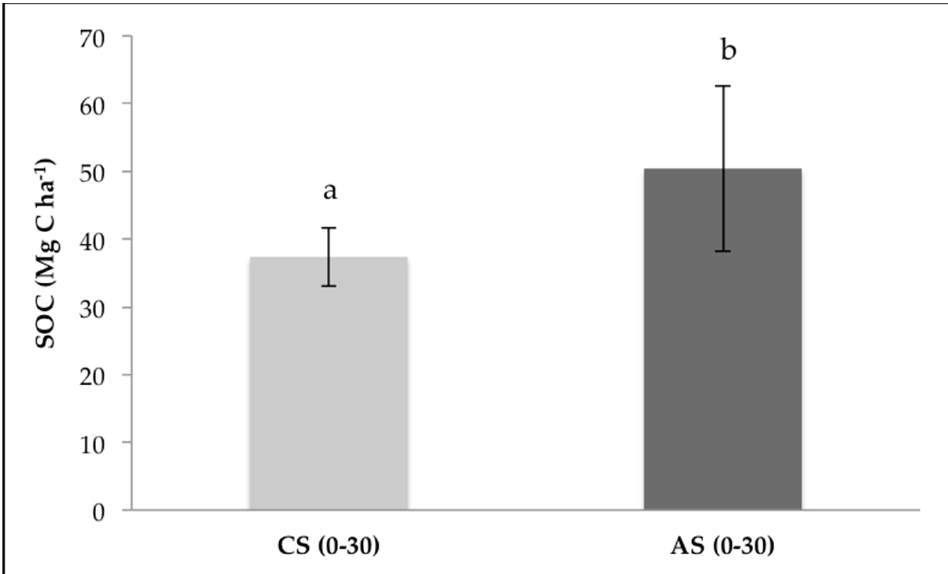
Figure 4. Comparison of the values of total soil organic carbon (SOC) (Mg C ha − 1 ) in the first 30 cm between cultivated soils (CS) and abandoned soils (AS); a, b: different letters indicate significant differences (Wilcoxon’s test, p < 0.05).